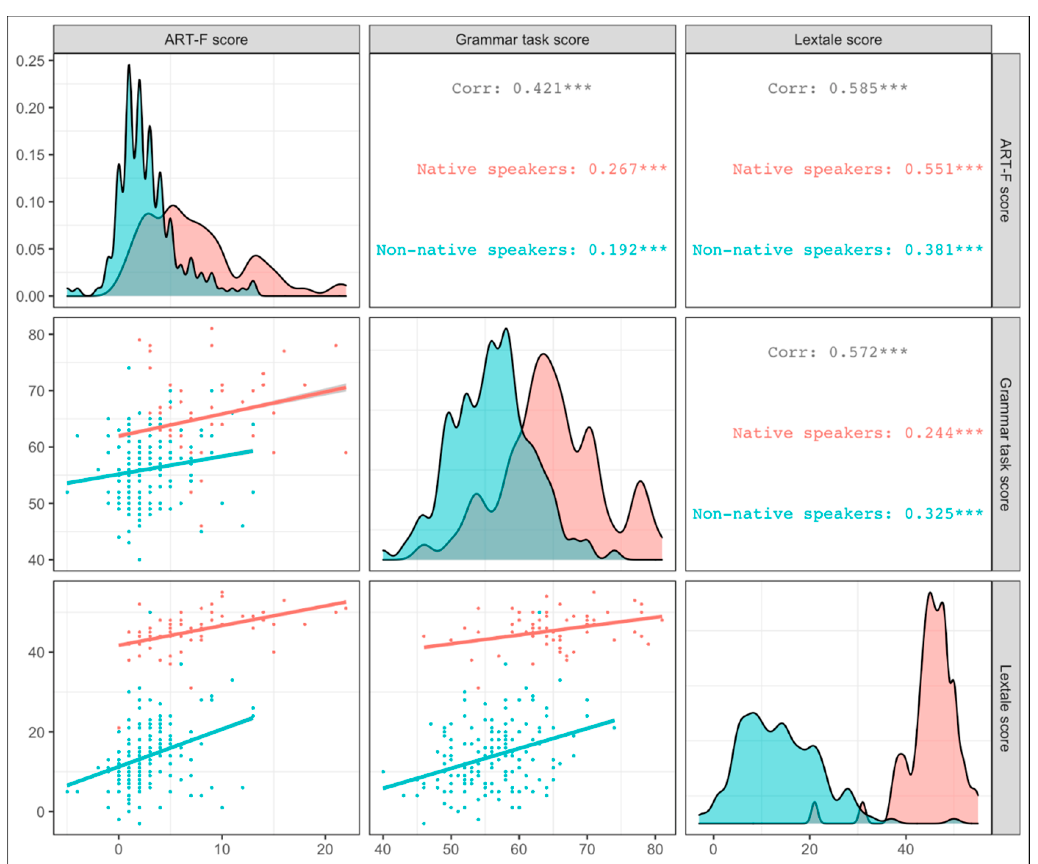
Figure 8. Correlations matrix: Spearman’s test of correlations of the ART-F, Lextale and grammar task scores by native and non-native speakers (Signif. code: “***” < 0.001).